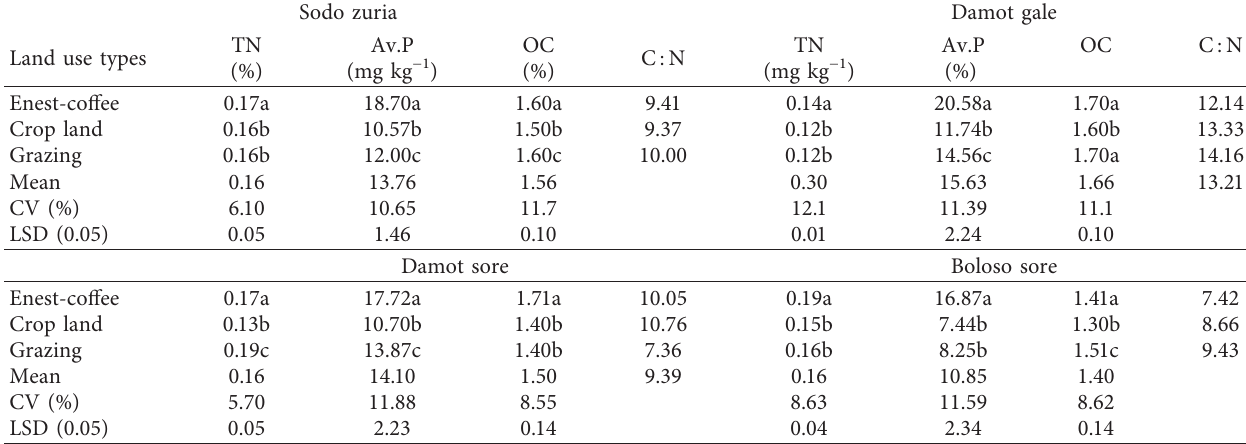
Table 7: Mean Values ( n � 108) of organic carbon (OC), total nitrogen (TN), and available Phosphorus (Av.P) in different locations and land uses.